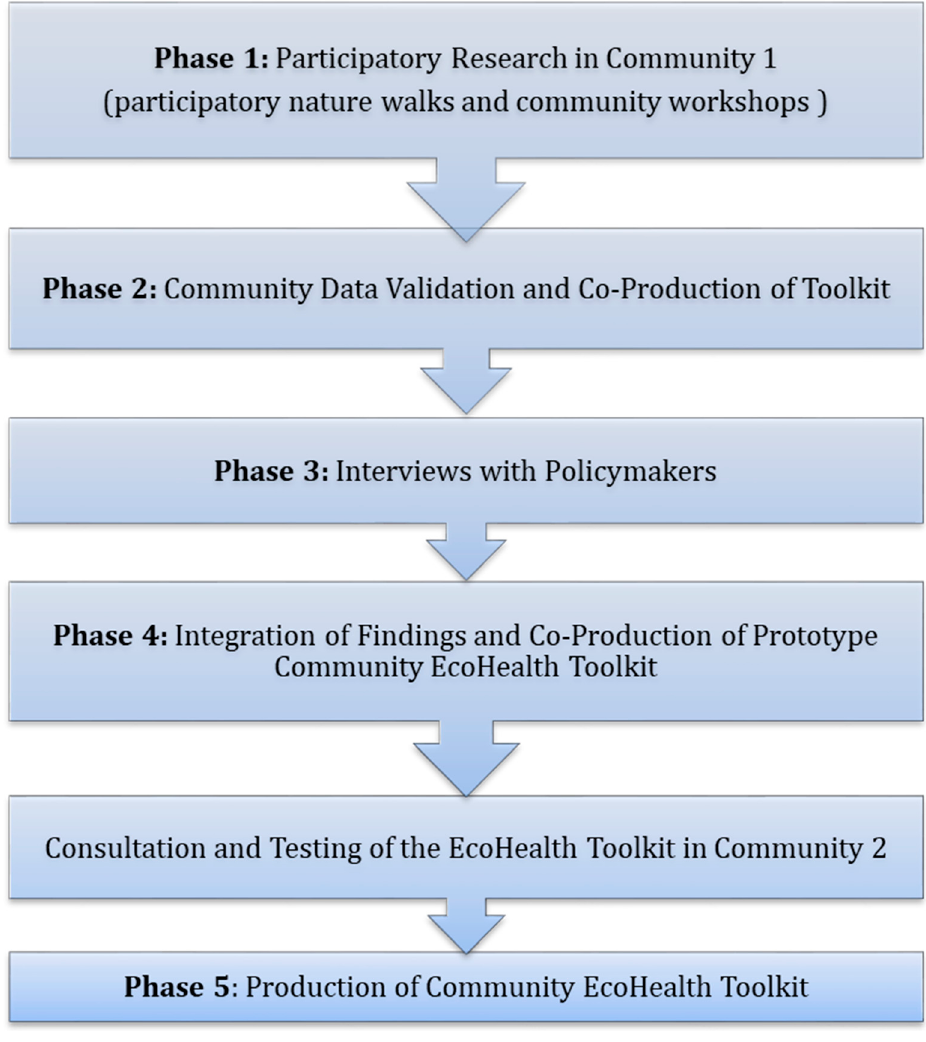
Figure 1. Phases of the Participatory Research Process.